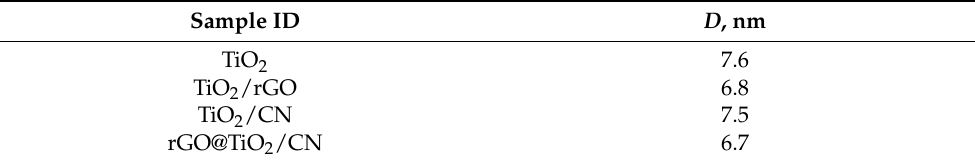
Table 1. Calculated crystallite size ( D , nm) of TiO 2 samples using the Scherrer equation. Sample